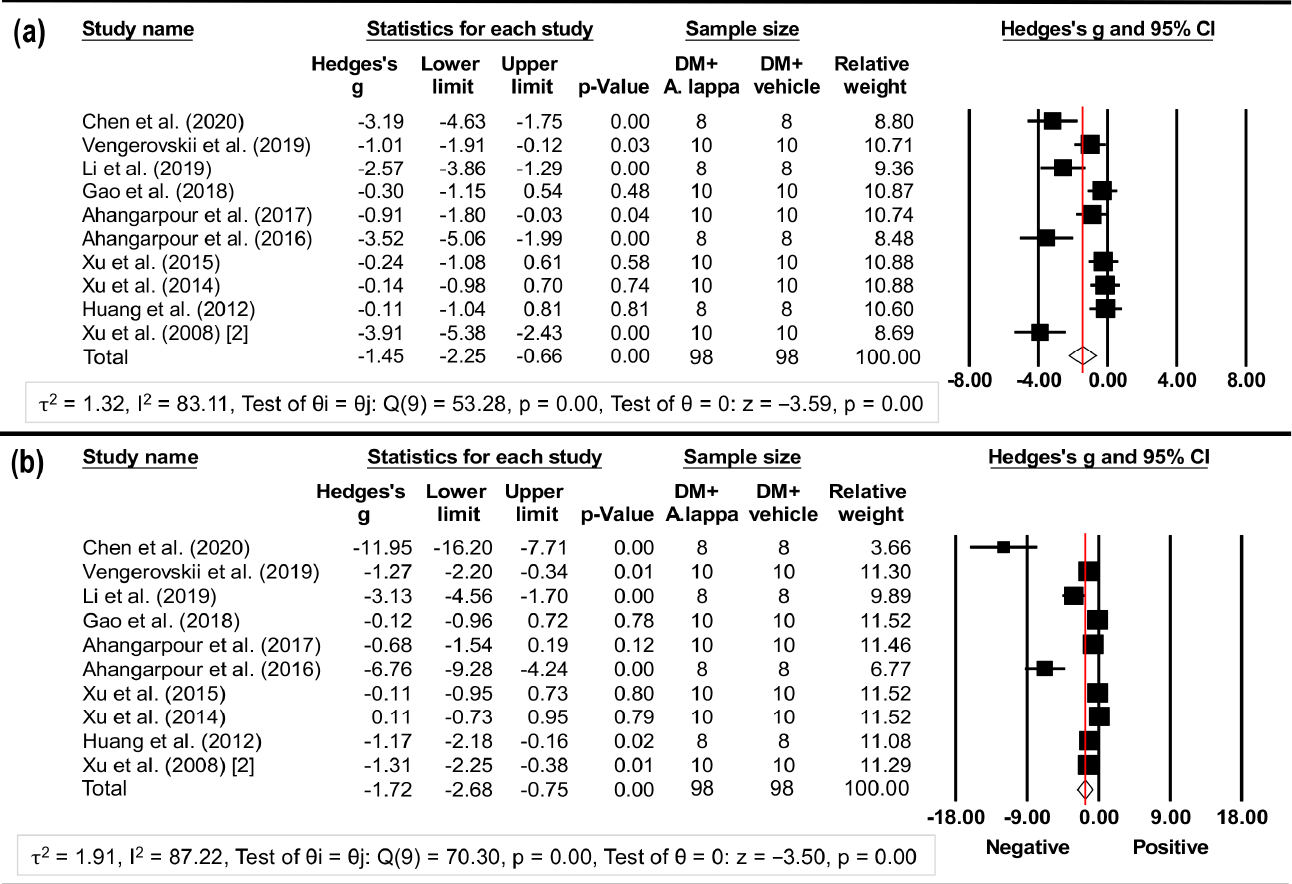
Figure 5. Meta-analysis of Hedges’ g of serum/plasma TG ( a ) and TC ( b ) levels of DM rodents given either A. lappa extracts and arctigenin-related compounds or vehicles. A red line indicates the pooled effect size.